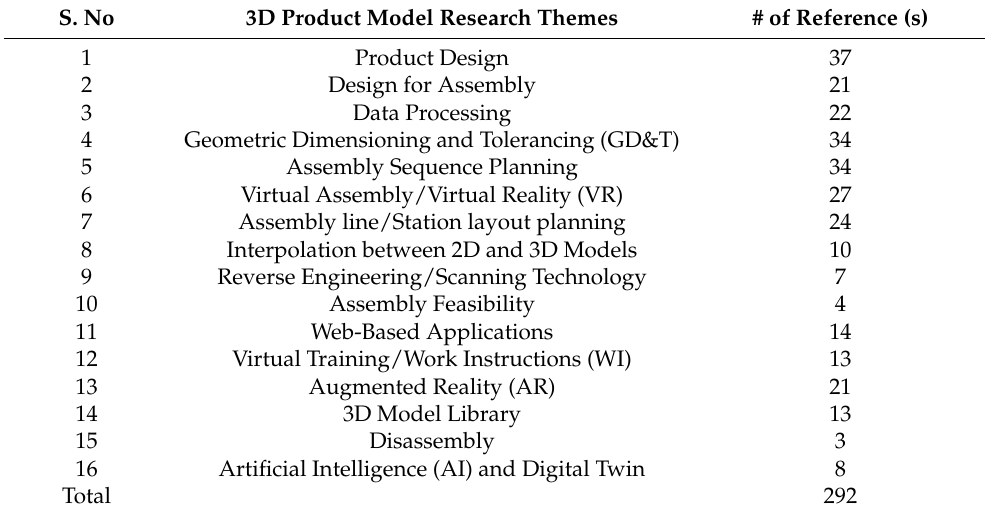
Table 2. Three-dimensional (3D) product model research themes and associated number of references. S. No